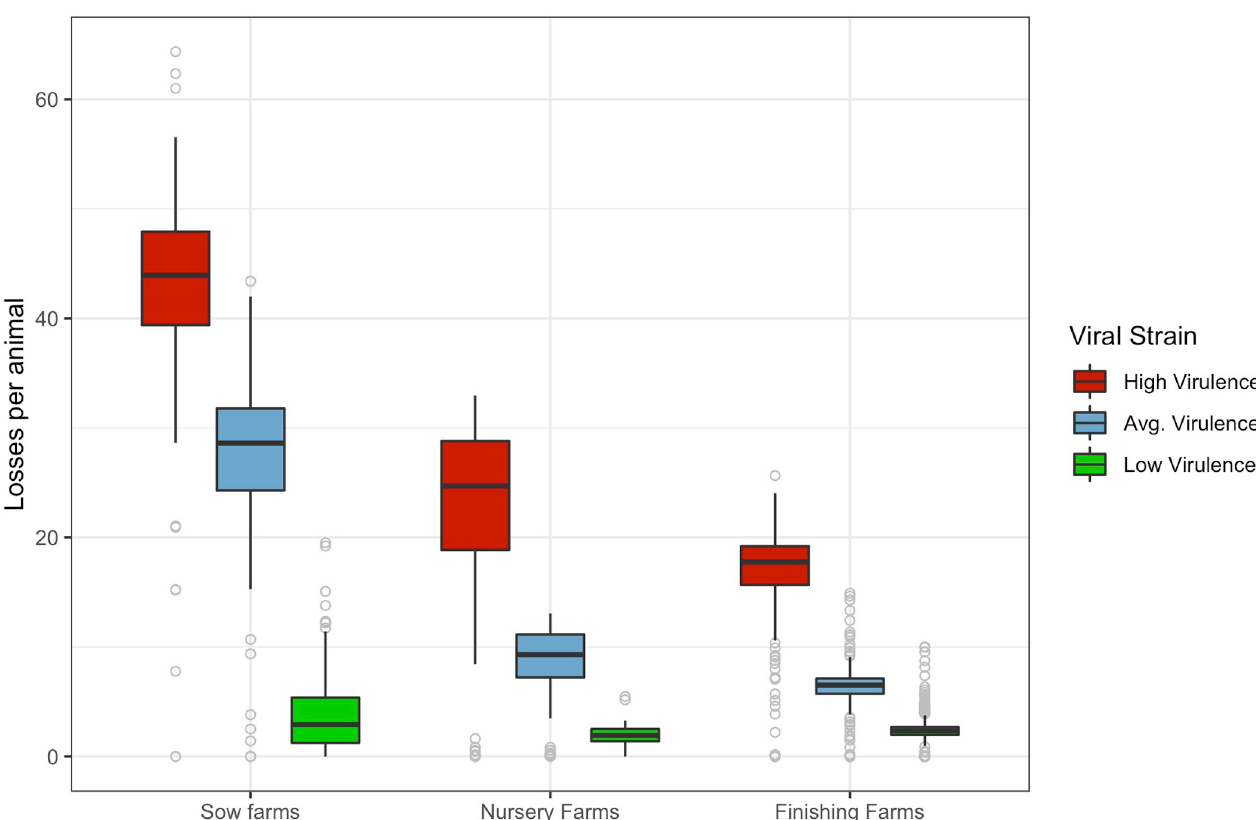
Fig 4. Distribution of losses per animal estimated under two viral strains in sow, nursery, and finishing farms.